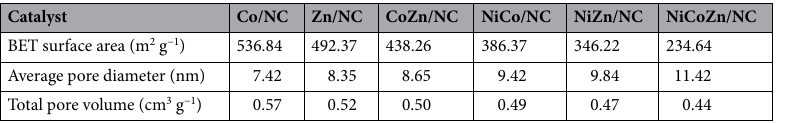
Table 3. BET surface area, average pore diameter, and the total pore volume of Co/NC, Zn/NC, CoZn/NC, NiCo/NC, NiZn/NC and NiCoZn/NC.